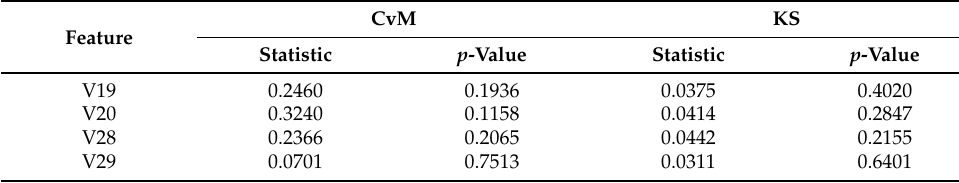
Table 6. Kolmogorov–Smirnov and Cramér–von Mises tests for the MPoE